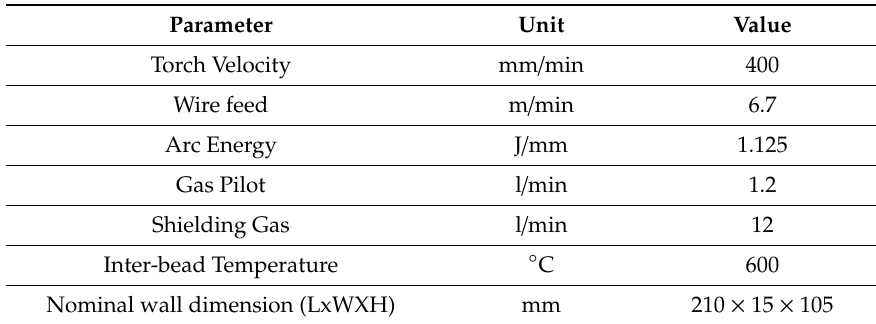
Figure 1. ( a ) ADDILAN V0.1 wire arc additive manufacturing (WAAM) ([20]) and ( b ) schematic process sequence for wall manufacturing. Table 2. Welding parameters used for sample deposition with wire arc additive manufacturing